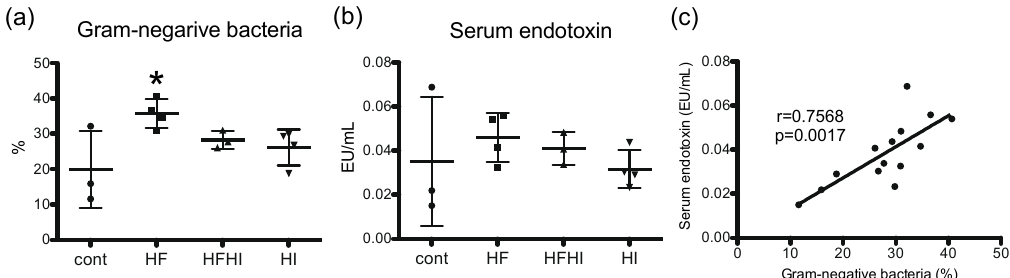
Figure 6. ( a ) Abundance of Gram-negative bacteria in the gut and ( b ) serum endotoxin level at week 30 ( n = 4 or 3 in each group). * p < 0.05 vs. control, by Tukey–Kramer’s multiple comparison. ( c ) Correlation analysis between gut Gram-negative bacteria and serum endotoxin. Data were analyzed by Pearson’s correlation. HF, high-fat; HFHI, high-fat and high-iron; HI, high-iron.